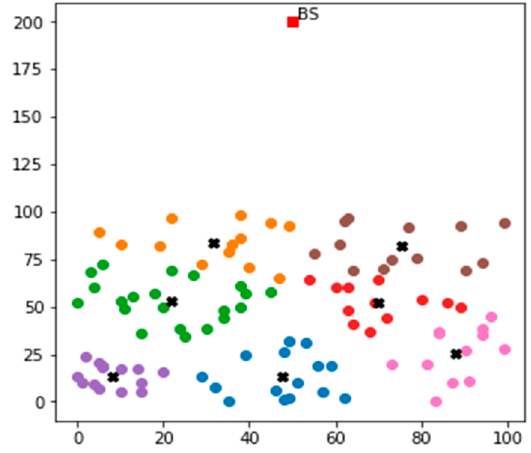
Figure 14. Network clustering using k-means algorithm.